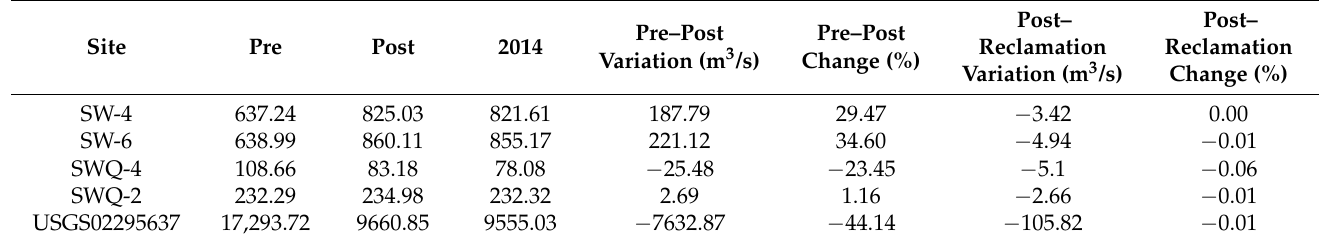
Table 10. Total cumulative simulated flow changes among the pre-mining, post-mining, and reclama- tion periods at the five sites (m 3